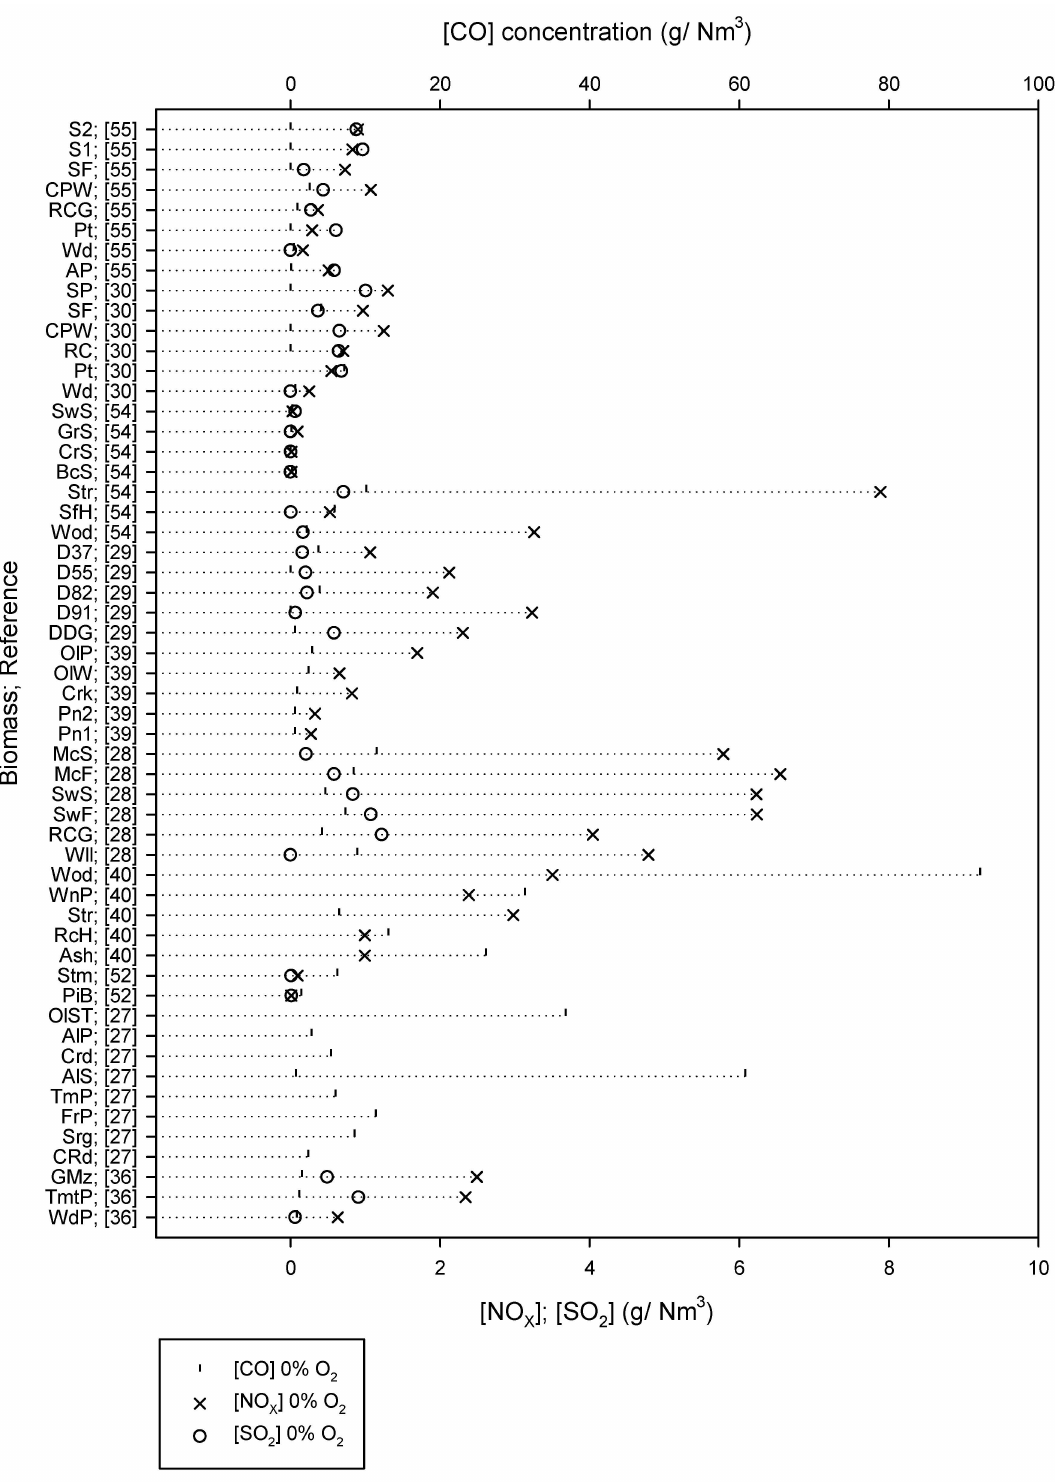
Figure A12. Toxic emission levels (CO, NO X, and SO 2 ), as reported in previous bibliographical works studying several biomass types and combustion device thermal outputs (see Tables A2 and